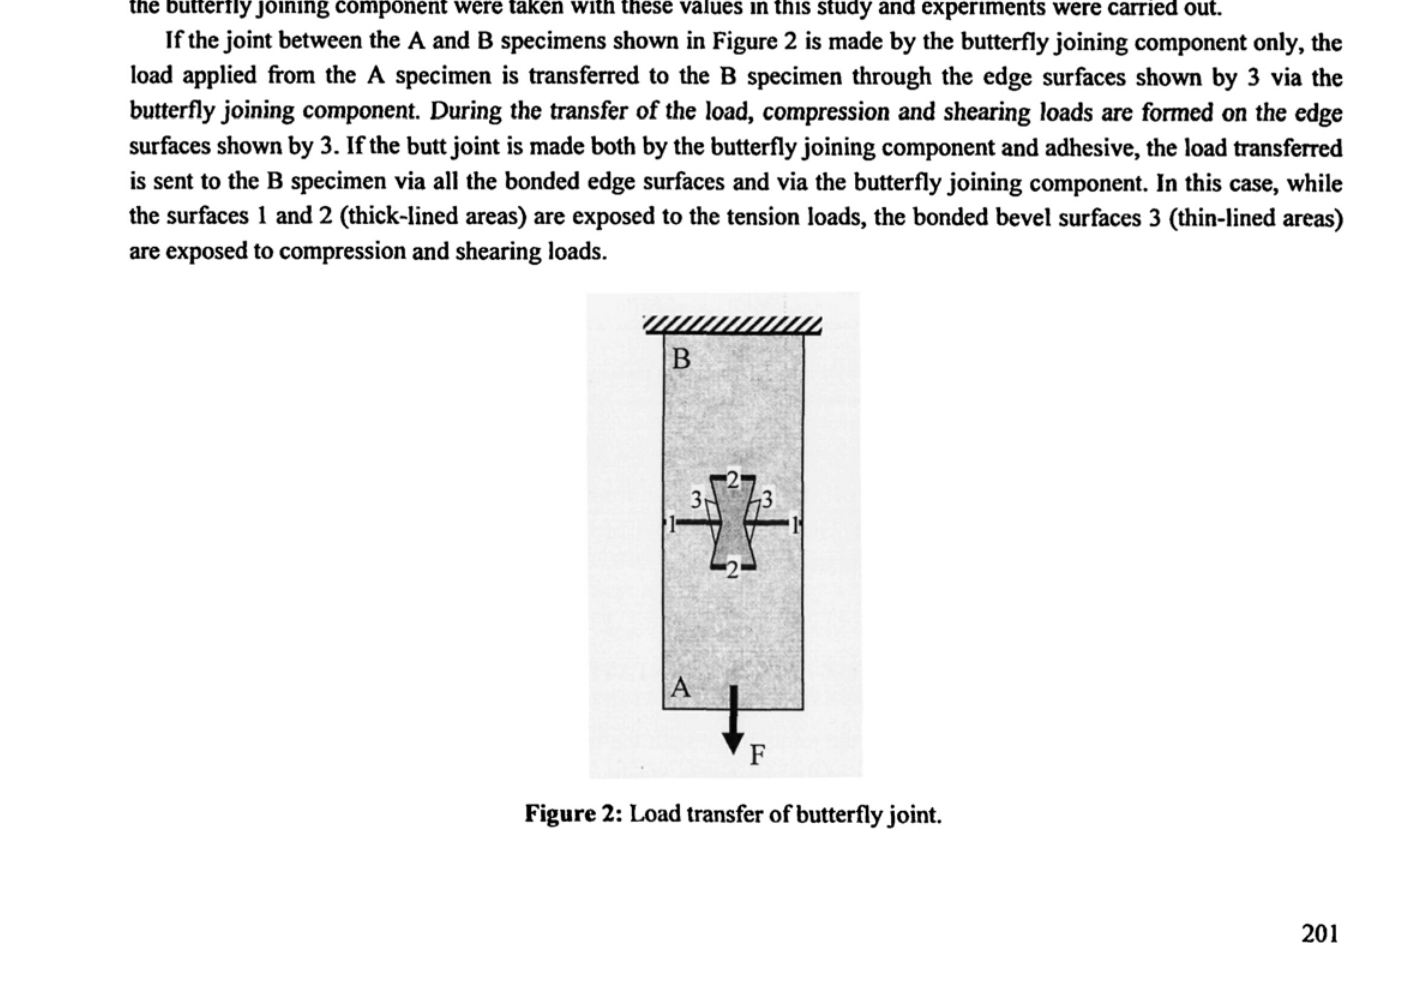
Figure 2: Load transfer of butterfly